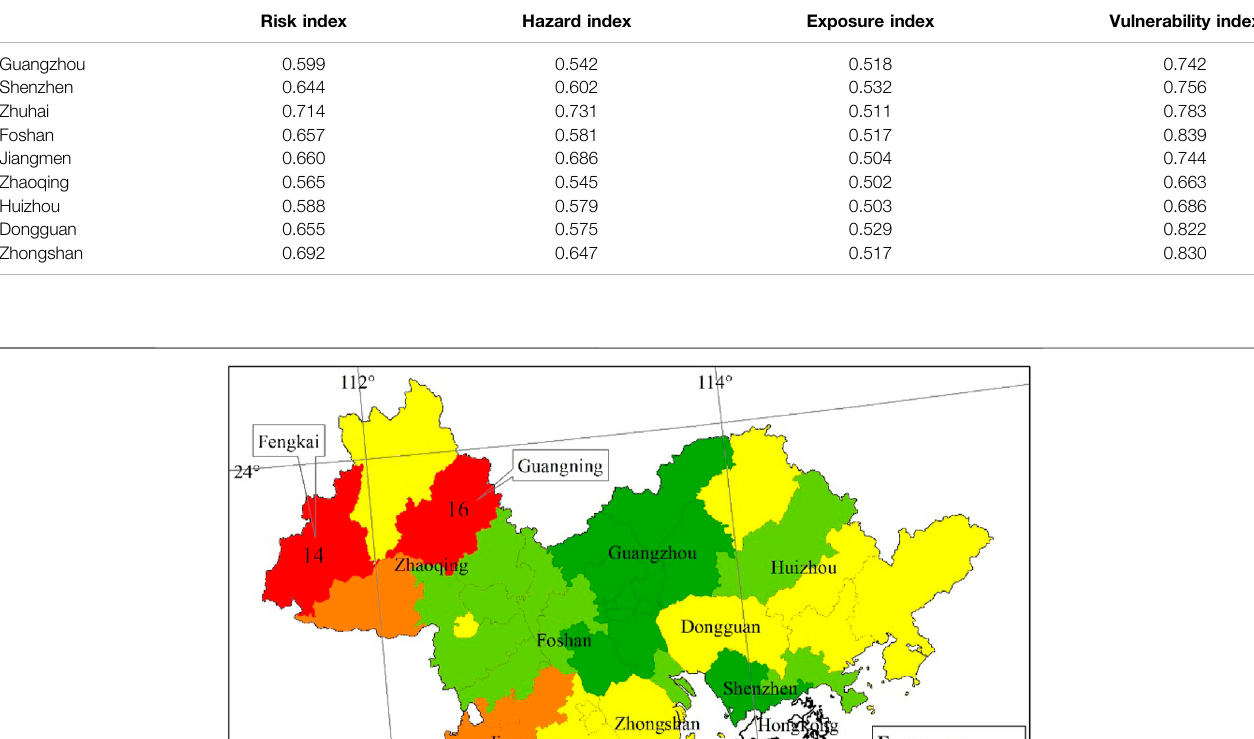
TABLE 7 | Risk, hazard, exposure, and vulnerability of typhoon – gale disaster chain in cities of the GBA.